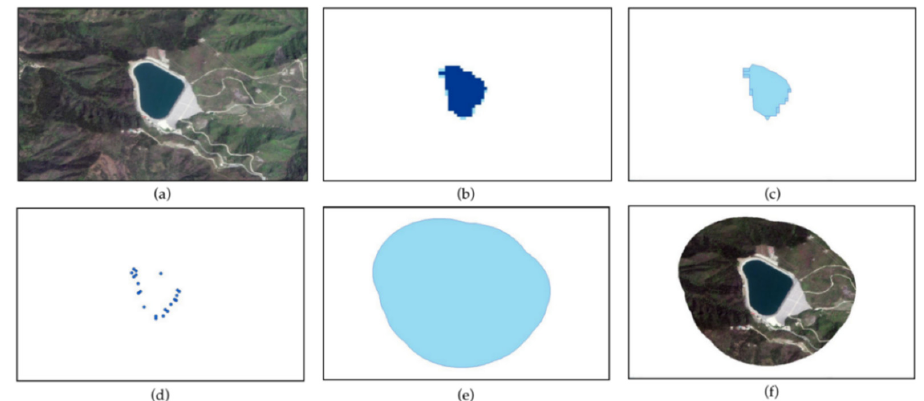
Figure 7. Construction of dam candidate areas based on the JRC-GSW raster. ( a ) Original image; ( b ) JRC-GSW raster; ( c ) water polygon; ( d ) water points; ( e ) water buffer; ( f ) dam candidate areas.